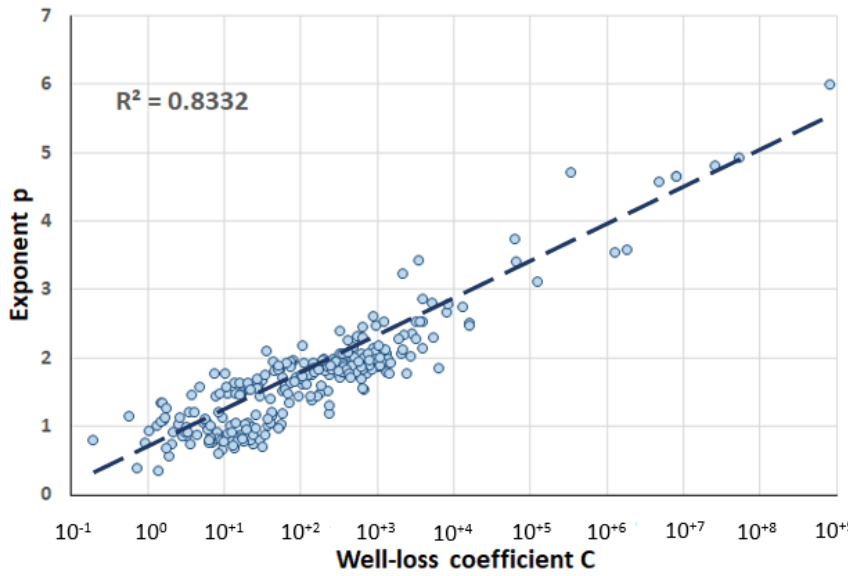
Figure 9. Plot of the exponent p values vs. well-loss coe ffi cient C values.